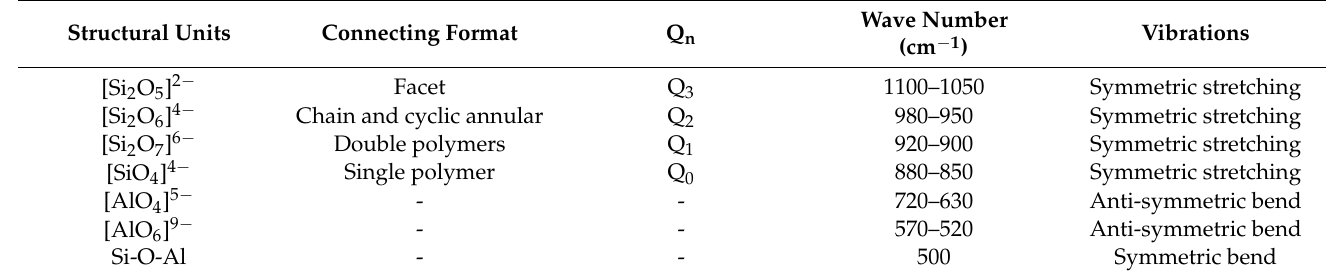
Table 2. Infrared active vibrational spectrum of the silicate and aluminate structural units.